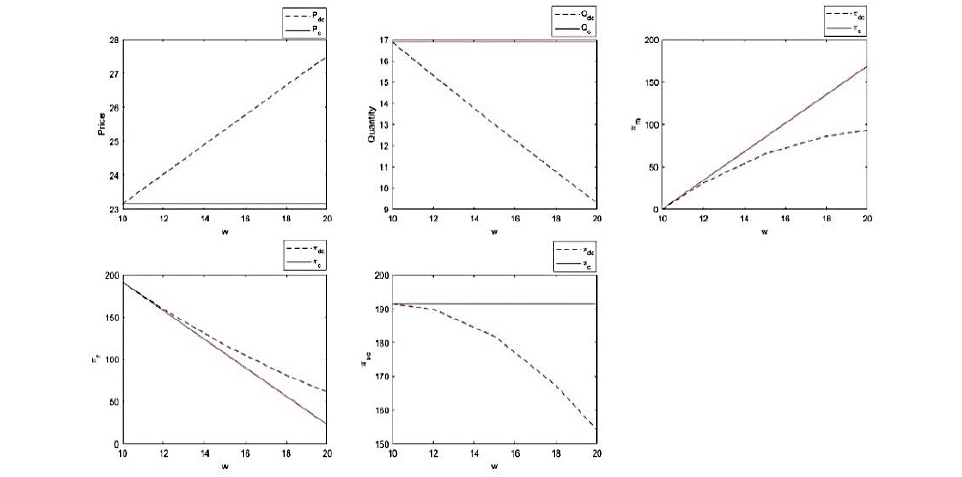
Fig. 3. The trend of variations in decision variables due to wholesale prices